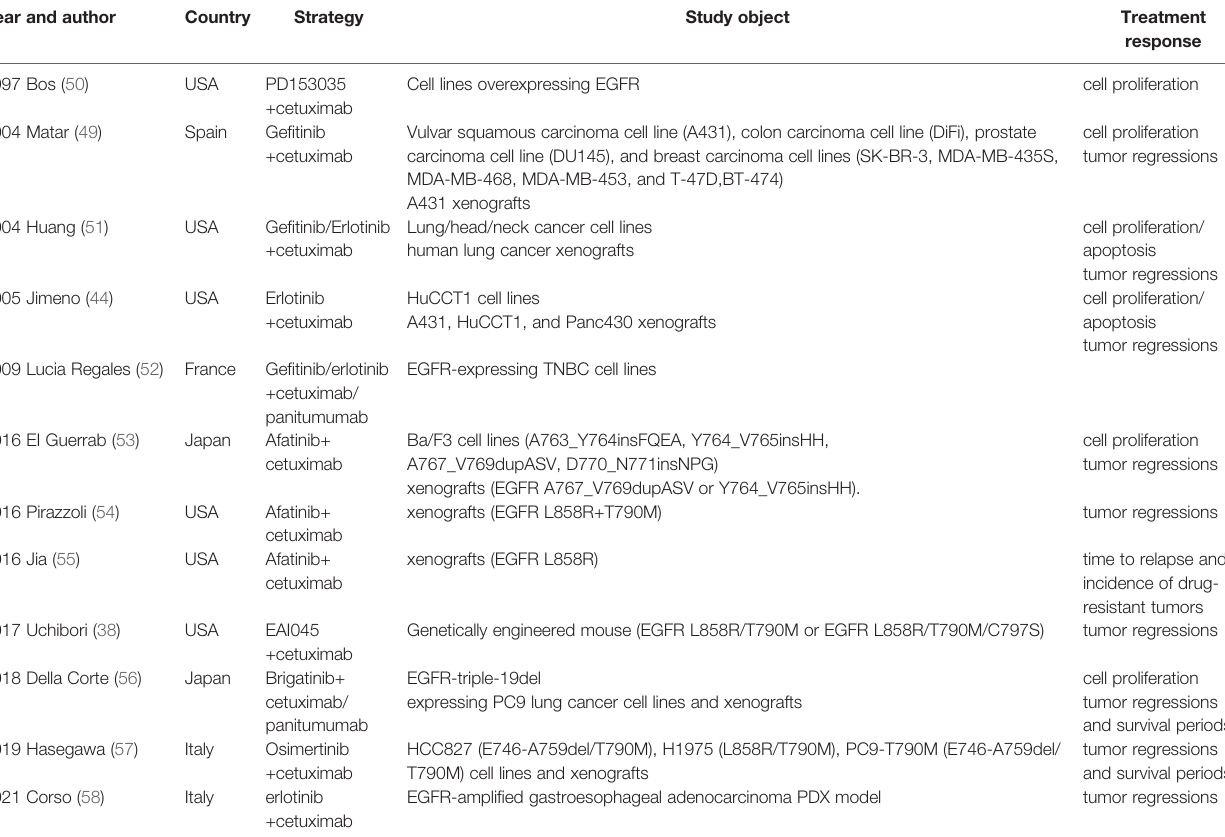
TABLE 1 | Preclinical data evaluating the “ sandwich ”